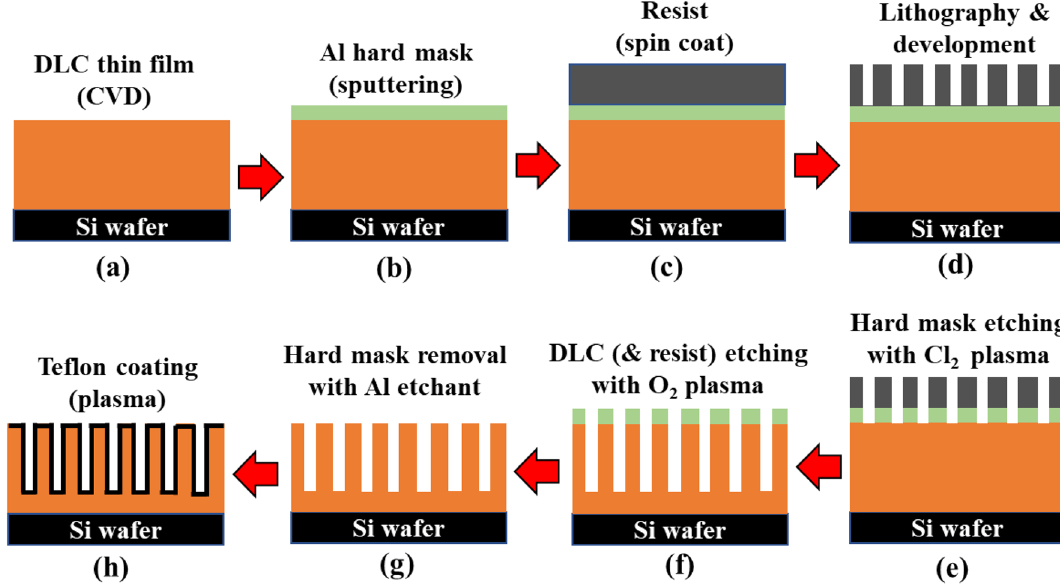
Figure 3. Schematic of process steps to fabricate DLC-based micropillared surfaces.